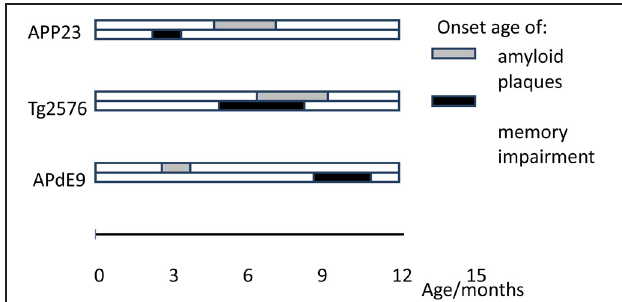
FIGURE 3 | Timeline of amyloid plaque deposition vs. memory impairment in the Morris swim task in three different APP transgenic mouse lines: APP23 (APPswe under Thy-1 promoter, Van Dam et al., 2003), Tg2576 (APPswe under hamster PrP promoter, Kawarabayashi et al., 2001; Westerman et al., 2002), and APdE9 (APPswe and deletion of exon 9 of presenilin-1 under mouse PrP, Garcia-Alloza et al., 2006; Minkeviciene et al.,